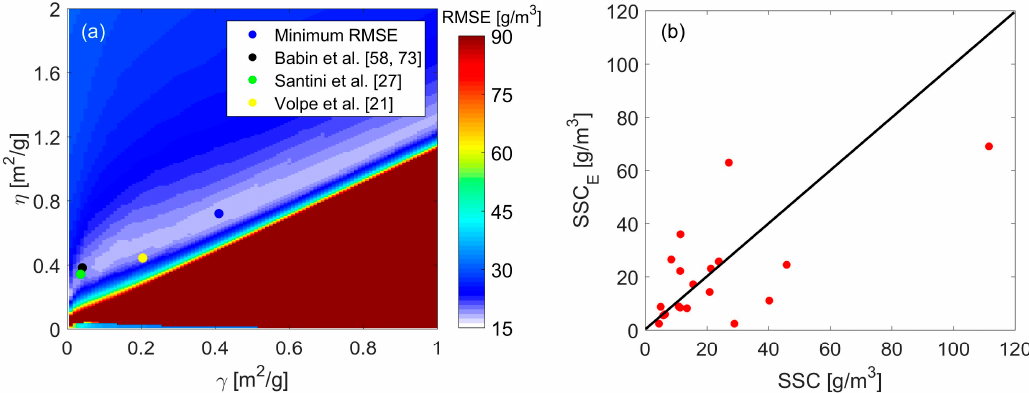
Figure 4. ( a ) Root-mean-square-error (RMSE) of the SSC calibration as a function of the suspended sediment specific absorption ( γ ) and backscattering ( η ) coefficients at around 400 nm using all Hyperion bands (RMSE values are color-coded based on the color bar legend), and ( b ) estimated SSC E versus measured SSC using optimal γ and η in ( a ).